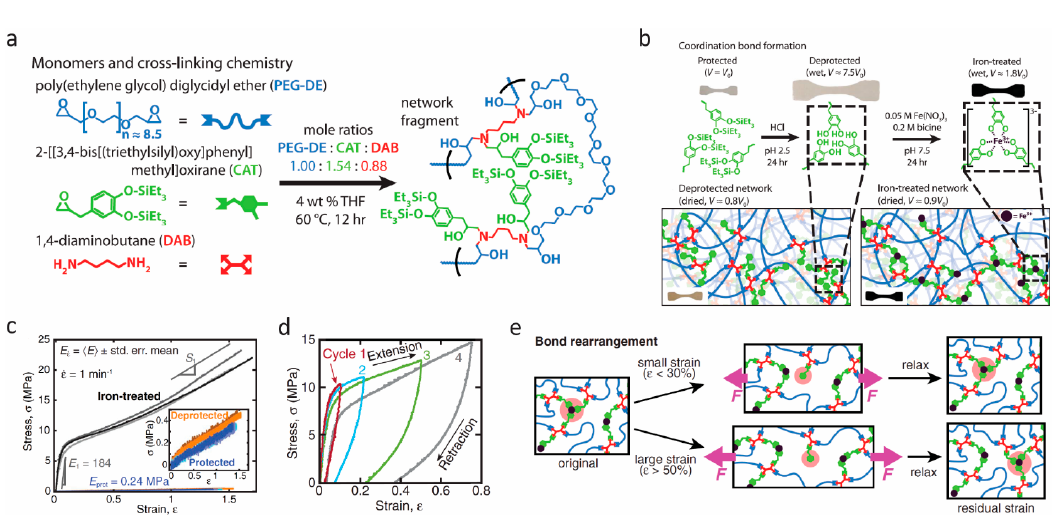
Figure 5. Self-healing elastomers. ( a ) The monomers and cross-linking chemistry. ( b ) Schematics of coordination bond formation following protected network, deprotected network, and ion-treated network. ( c ) Stress–strain curves in uniaxial tensile tests. ( d ) Sequential loading–unloading cycles with rest intervals of 30 min. ( e ) Proposed mechanism for the recovery process based on bond rearrangements. From Filippidi et al. [70]. Reprinted with permission from AAAS.